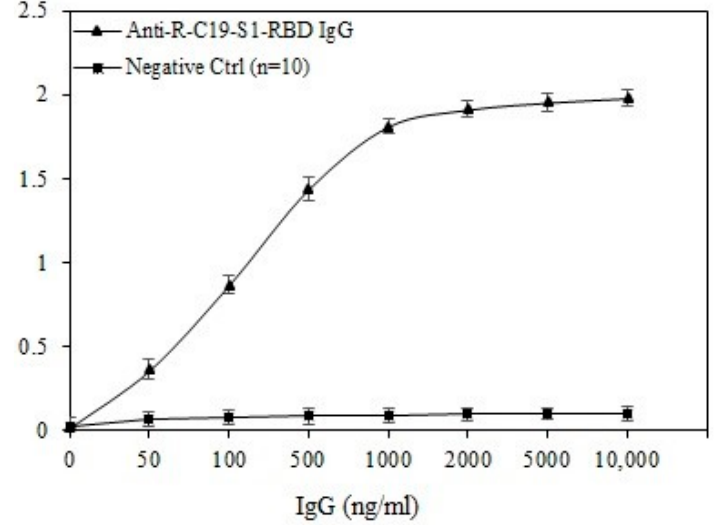
Figure 5. Standard graph between COVID-19 virus protein antigen S1-RBD vs. IgG against S1-RBD.